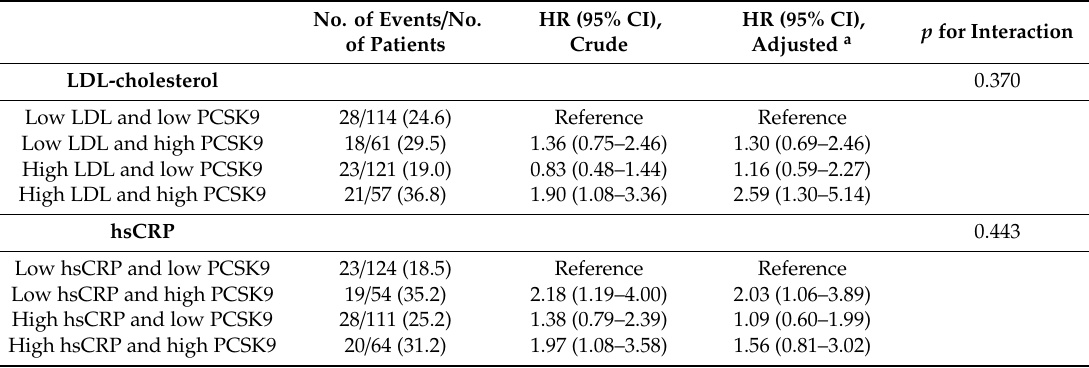
Table 5. Hazard ratios of plasma tertile 3 PCSK9 for composite events based on predefined subgroup. No. of Events /